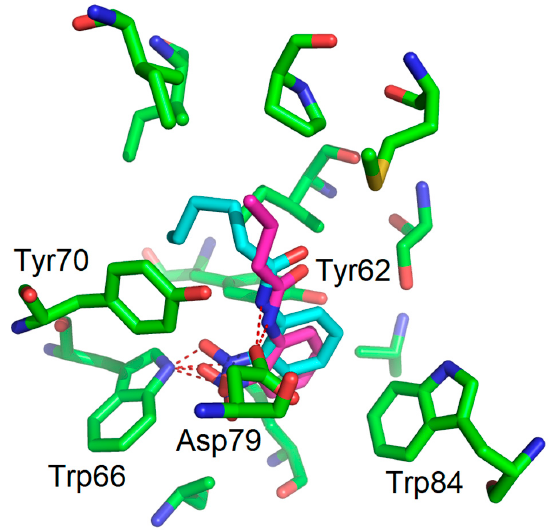
Figure 6. Proposed binding mode obtained as a result of the docking experiment with compound 1 (magenta) and 2 (cyan) showing that the phenyl group and the alkyl chain fit within the LuxR model binding site.